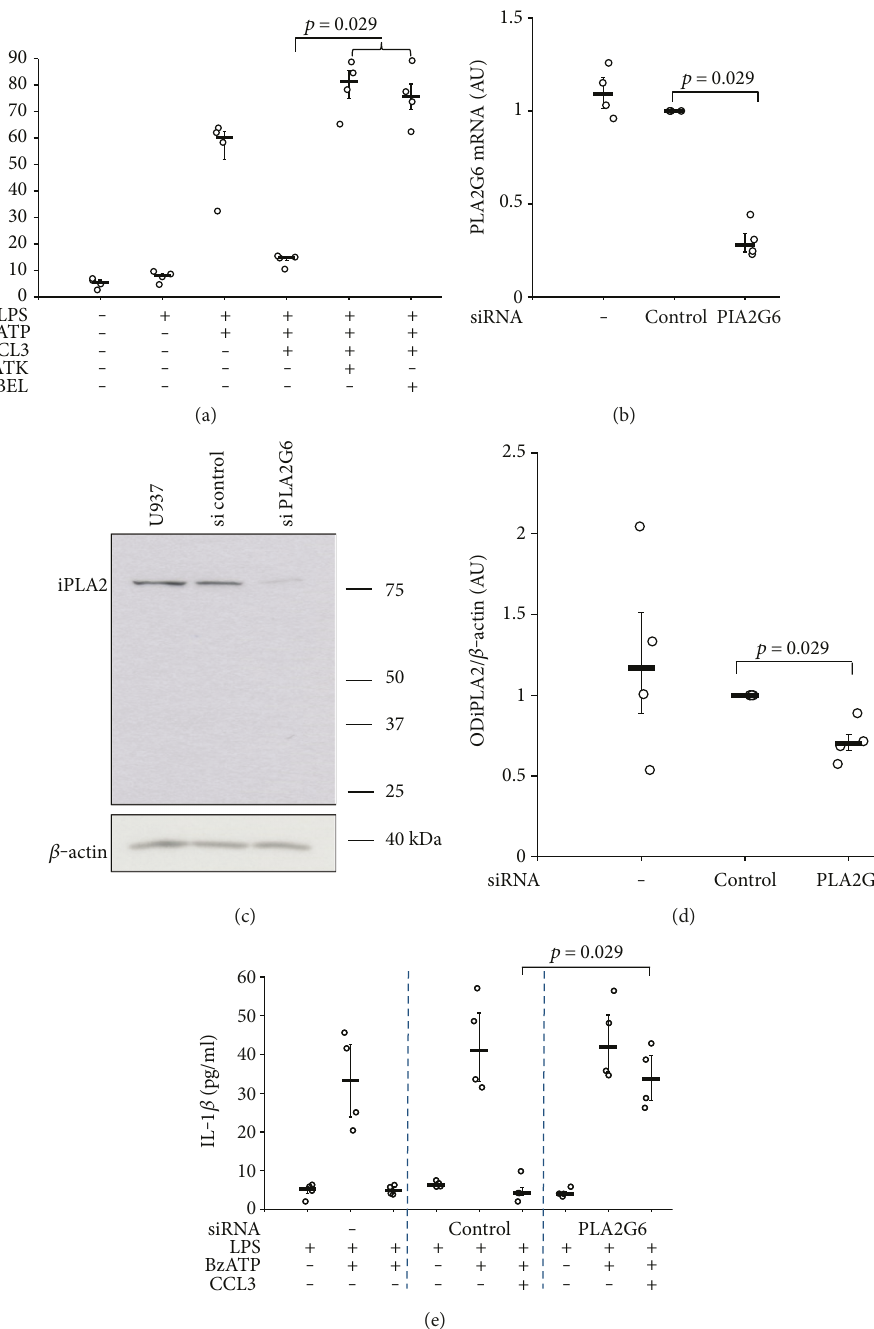
Figure 6: CCL3 signaling involves calcium-independent phospholipase A2 (iPLA2). Human monocytic U937 cells were primed with LPS (1 μ g/ml, 5h) and activated 2 ′ (3 ′ )-O-(4-Benzoylbenzoyl)adenosine-5 ′ -triphosphate (BzATP; 100 μ M, 30 min). The release of IL-1 β to the cell culture supernatant was measured by ELISA. (a) CCL3 (10 ng/ml) inhibited the release of IL-1 β in response to BzATP. The general PLA2 inhibitor arachidonyl tri fl uoromethyl ketone (ATK) and the speci fi c iPLA2 inhibitor bromoenol lactone (BEL) reversed CCL3- dependent inhibition. (b – e) Expression of iPLA2 by U937 cells was silenced by siRNA ( PLA2G6 ); scrambled siRNA served as control. Silencing of PLA2G6 expression was e ffi cient as revealed by real-time RT-PCR (b) and by Western blotting (c, d). Data in (b) and (d) are given as arbitrary units. (c, d) In Western blotting experiments, β -actin served as a loading control, the optical density (OD) of the immunopositive bands was measured, and the ratio of the OD of iPLA2 and β -actin was formed. (b, d) Values obtained for cells treated with siRNA targeting CCR1 were statistically compared to those transfected with control siRNA. (e) After treatment with siRNA targeting PLA2G6 expression, the inhibitory e ff ect of CCL3 on IL-1 β release was blunted. In untreated control cells and upon transfection of control siRNA, CCL3 was e ff ective. Data are presented as individual data points, bars indicate median, and whiskers percentiles are 25 and 75, n = 4 ,